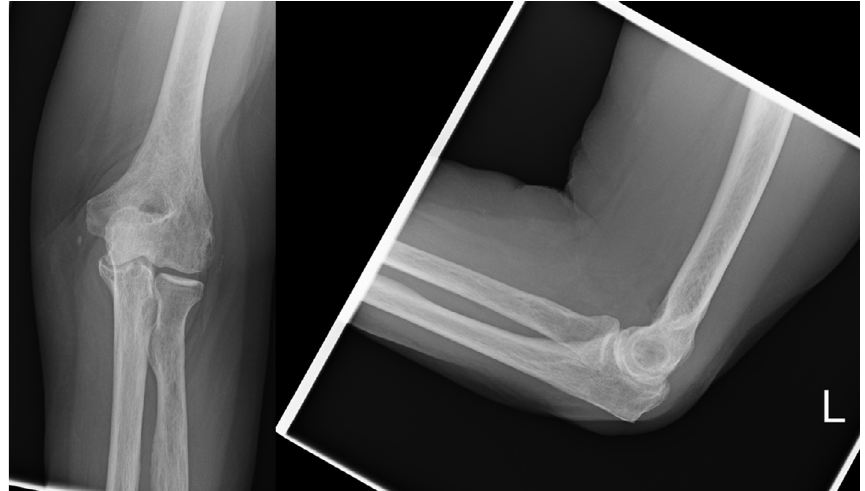
Figure 8. Elbow AP and lateral radiographs two years post